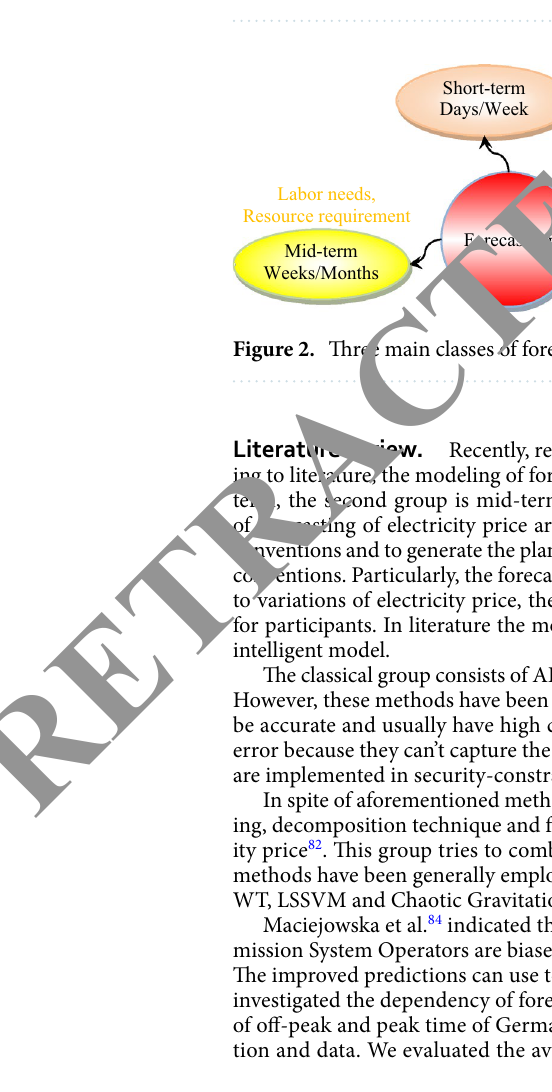
Figure 1. Graphical view of electricity price which directly reflects important and effective factors in price fluctuations.